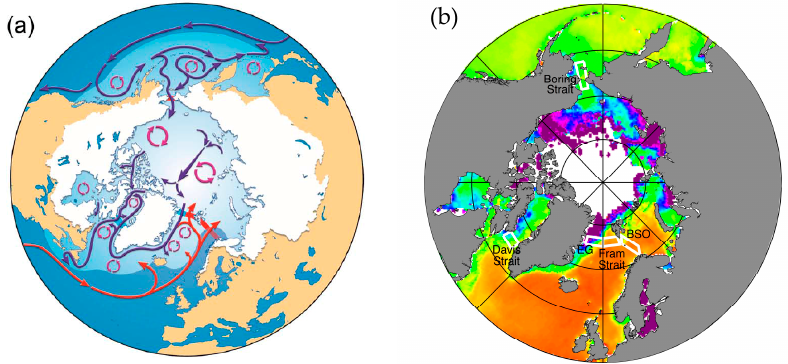
Figure 9. ( a ) From Carmack et al., 2015 [14]. Schematic maps of the major ocean currents (long arrows), the four Arctic Ocean gateways in Fram Strait, the Barents Sea Opening, Davis Strait, and Bering Strait (thick bars with red denoting inflow and blue denoting outflow), the gyral circulation patterns (circular arrows), the salt-stratified ocean domains are shown in light blue, and the All Arctic Regions definition of the terrestrial contributing areas shown in white. ( b ) Locations of the Arctic Gateways indicated on SMAP SSS gridded fields (three years mean), which were used in the calculation of mean SSS and the percentage of ice-free area (Figure 10). In this study, the Fram Strait is divided into two parts where currents flow in opposite directions: one between east Greenland coast and 0 ◦ longitude, the other from 0 ◦ longitude to the west coast of Svalbard. Exact coordinates of the four corners of the polygon used for each gateway are given in Table 3.